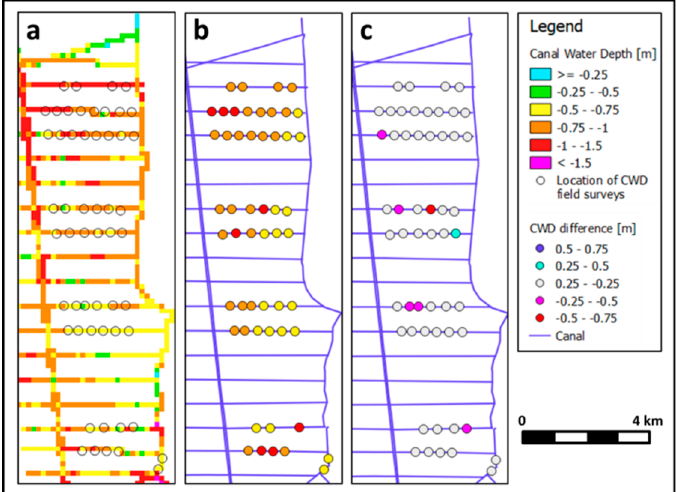
Figure 6. LiDAR-derived CWD ( a ) compared with field measurements on the same day (plus/minus one day) ( b ) for a validation plantation area in South Sumatra. ( c ) Differences were mostly within 0.25 m. These data were collected in a dry period (August 2018), so water levels were mostly more than 0.5 m below the surface, but still less than 1 m in this area.